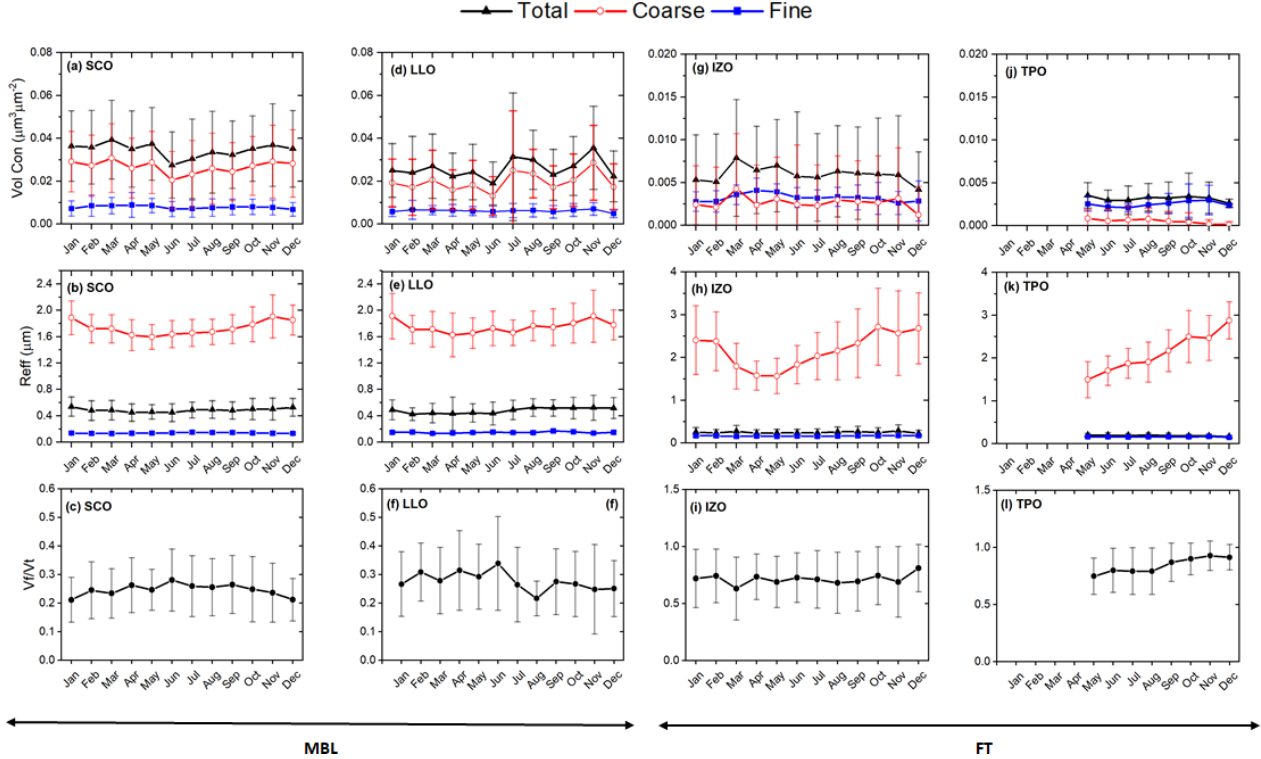
Figure 6. Monthly mean volume particle concentration (VolCon; µm 3 µm − 2 ) and effective radius ( R eff ; µm) of the total (black), coarse (red) and fine (blue) modes and the fine-mode volume fractions ( V f /V t ) at SCO (a, b, c) , LLO (d, e, f) , IZO (g, h, i) and TPO (j, k, l) under background conditions. The error bars indicate the standard deviation. Note the different scales used for the stations within the MABL and those within the